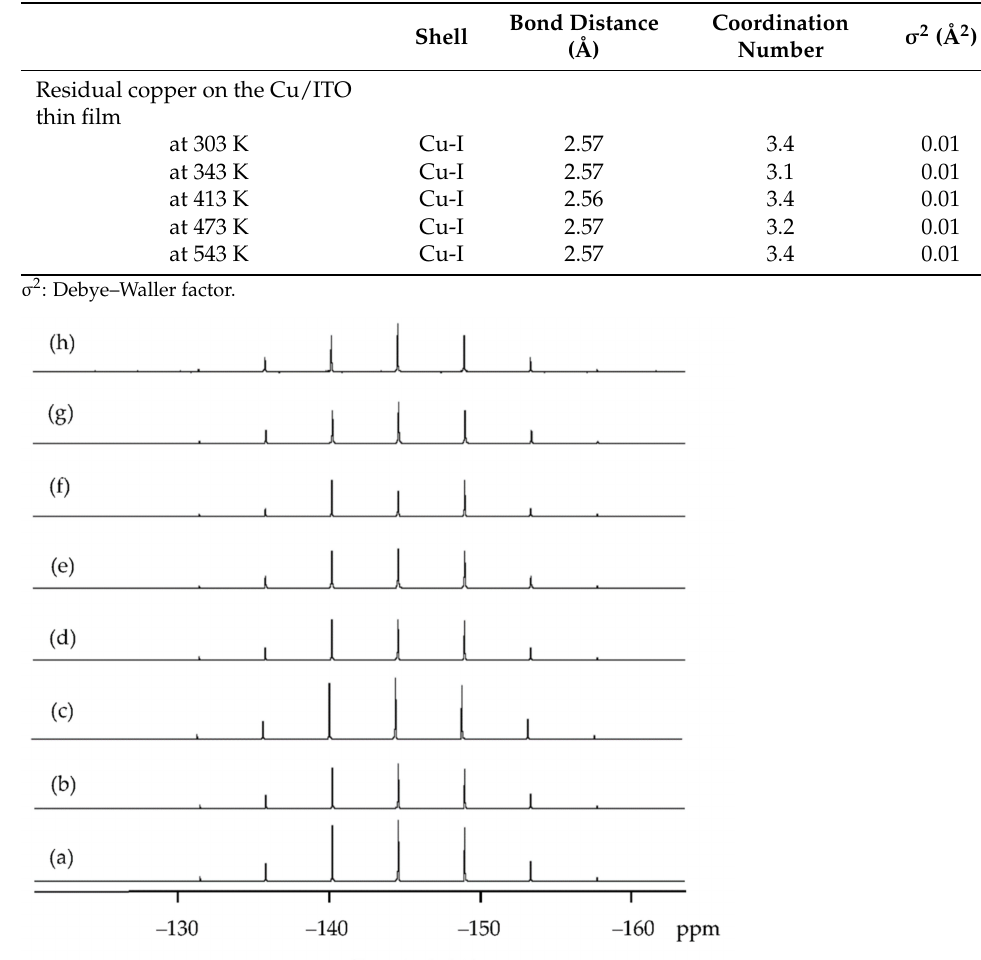
Table 2. Speciation of residual copper on the Cu/ITO thin film during extraction with the IL-I at 298–543 K.